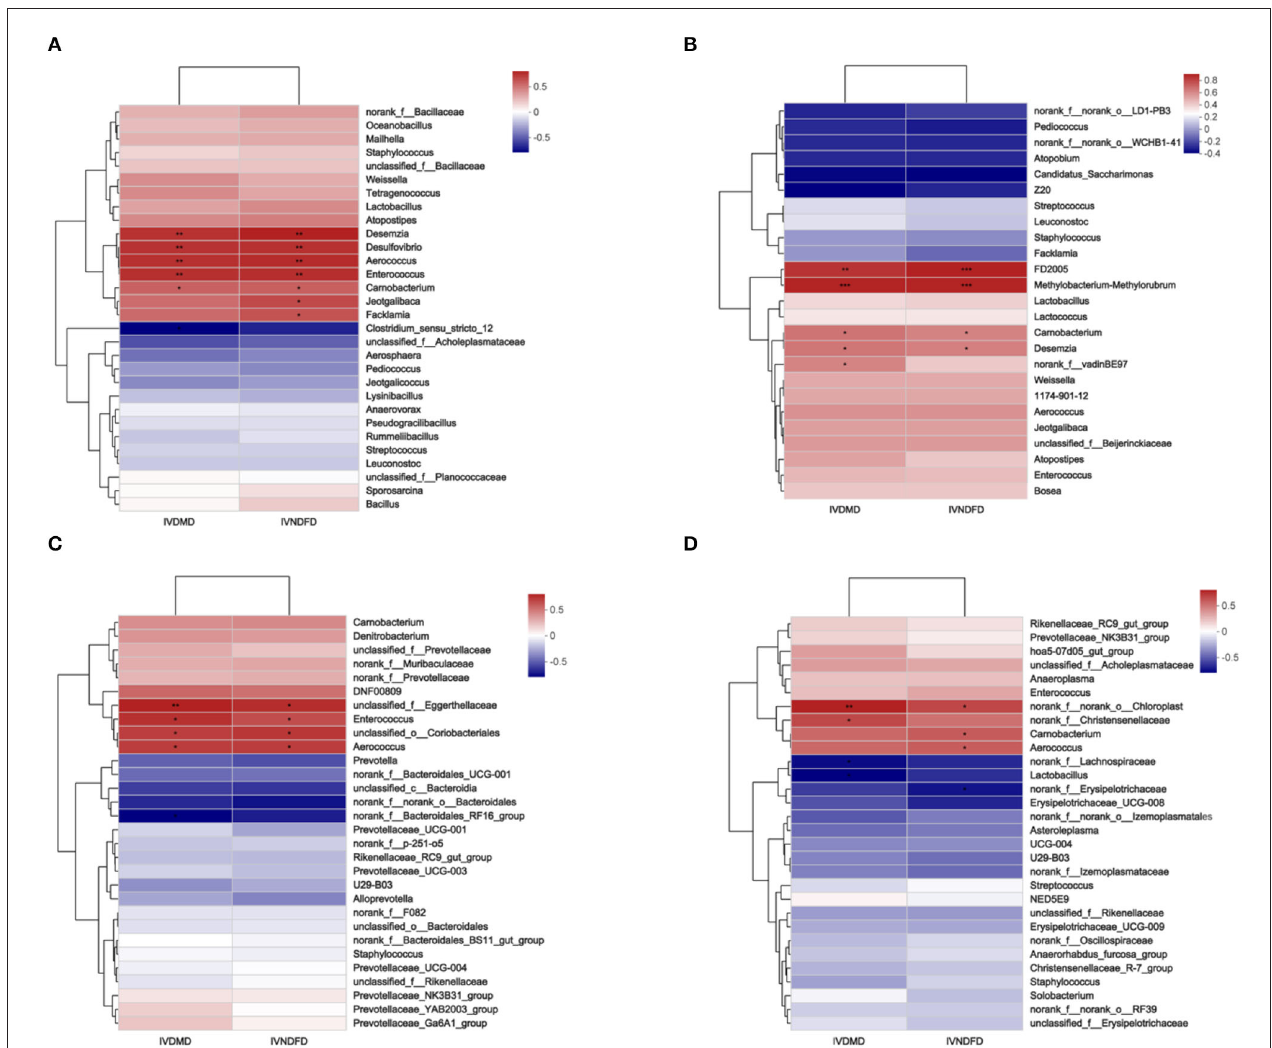
FIGURE 6 | Correlations among the colonization microbial on surface of RS samples after incubation 0.5h (A) , 4h (B) , 12h (C) , and 24h (D) and in vitro degradability [our previously published research ( Ma et al., 2020)]. Con, without additive control; U, 5% urea; CU, 9% CSL + 2.5% urea; C5U, 9% CSL + 5% urea. *, **, and *** indicate the significant correlations at P < 0.05, 0.01, and 0.001. IVDMD, in vitro dry matter degradability, IVNDFD, in vitro neutral detergent fiber